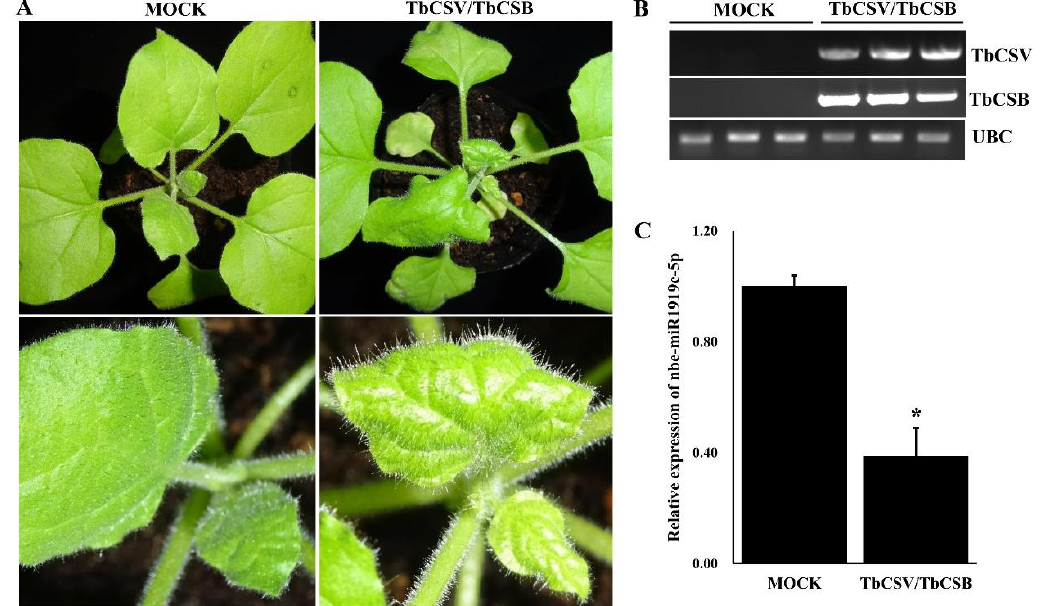
Figure 1. Co-infection of tobacco curly shoot virus (TbCSV) and its betasatellite (TbCSB) in N. benthamiana plants. ( A ) Leaf curling symptoms in a N. benthamiana plant co-inoculated with TbCSV and TbCSB. The plant inoculated with Agrobacterium cells without viral constructs (Mock) was used as control. The plants were photographed at 7 days post agro-infiltration (dpai). ( B ) Analysis of TbCSV and TbCSB DNA accumulations through PCR. The expression of N. benthamiana Ubiquitin C gene ( UBC ) was used as an internal control. ( C ) Analysis of nbe-miR1919c-5p expression in the mock- and the TbCSV/TbCSB-inoculated plants through qRT-PCR. Statistical differences between the treatments were determined by the Student’s t -test, * P < 0.05.